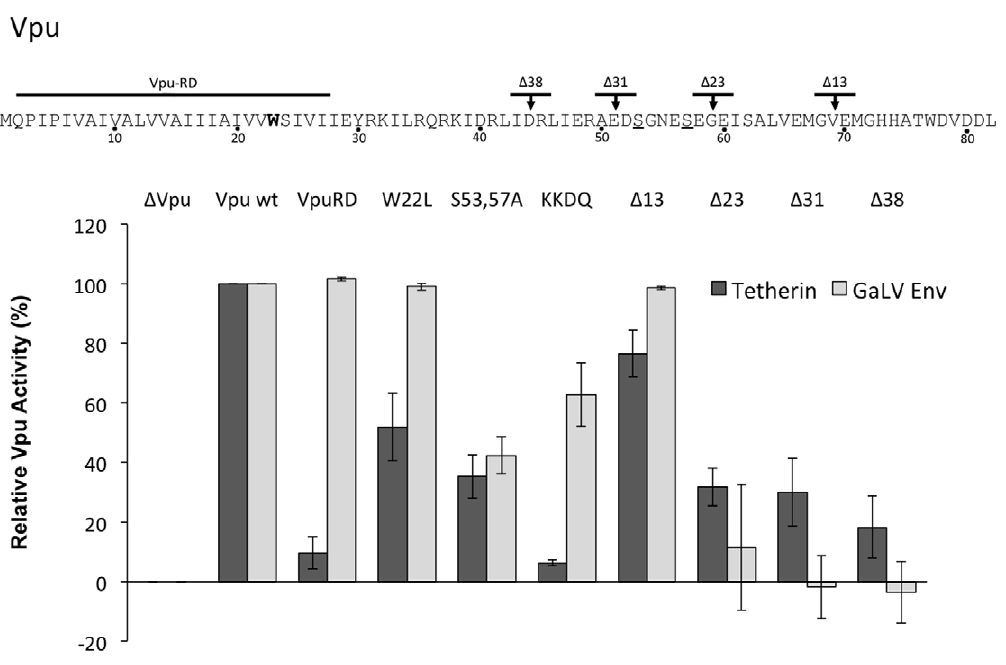
Figure 2. Features required for Vpu-mediated antagonism of targets, tetherin (dark bars) and GaLV Env (light bars). (Top) Location of VpuRD, W22L (bold), critical serines 53,57 (underline) and truncations (arrows) are noted in the Vpu schematic. (Bottom) Relative Vpu activity is shown as mean averages (n=3–4, 6 SE) calculated by normalizing infectious units per ml for each mutant Vpu relative to Vpu wildtype (Vpu wt) (100%) and no Vpu ( D Vpu) (0%).